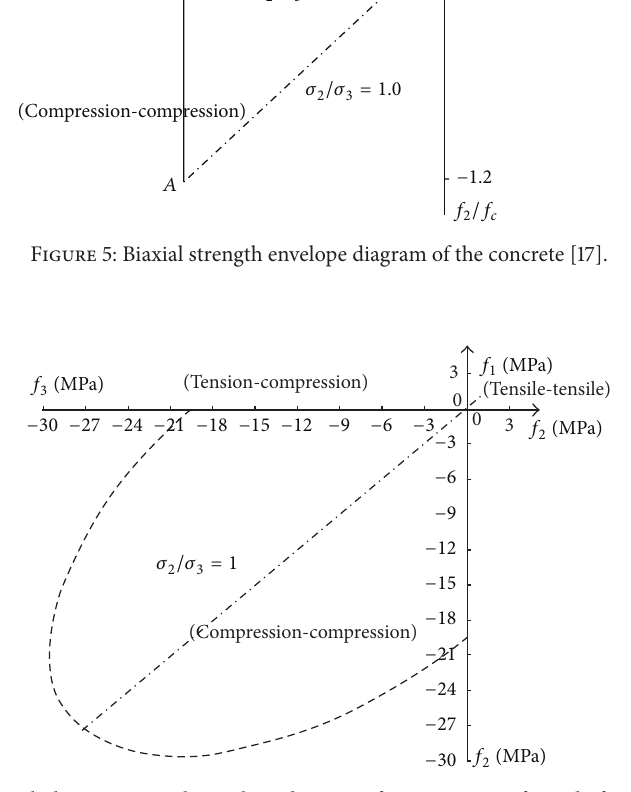
Figure 6: Biaxial ultimate strength envelope diagram of C20 concrete after 7 d of standard curing.